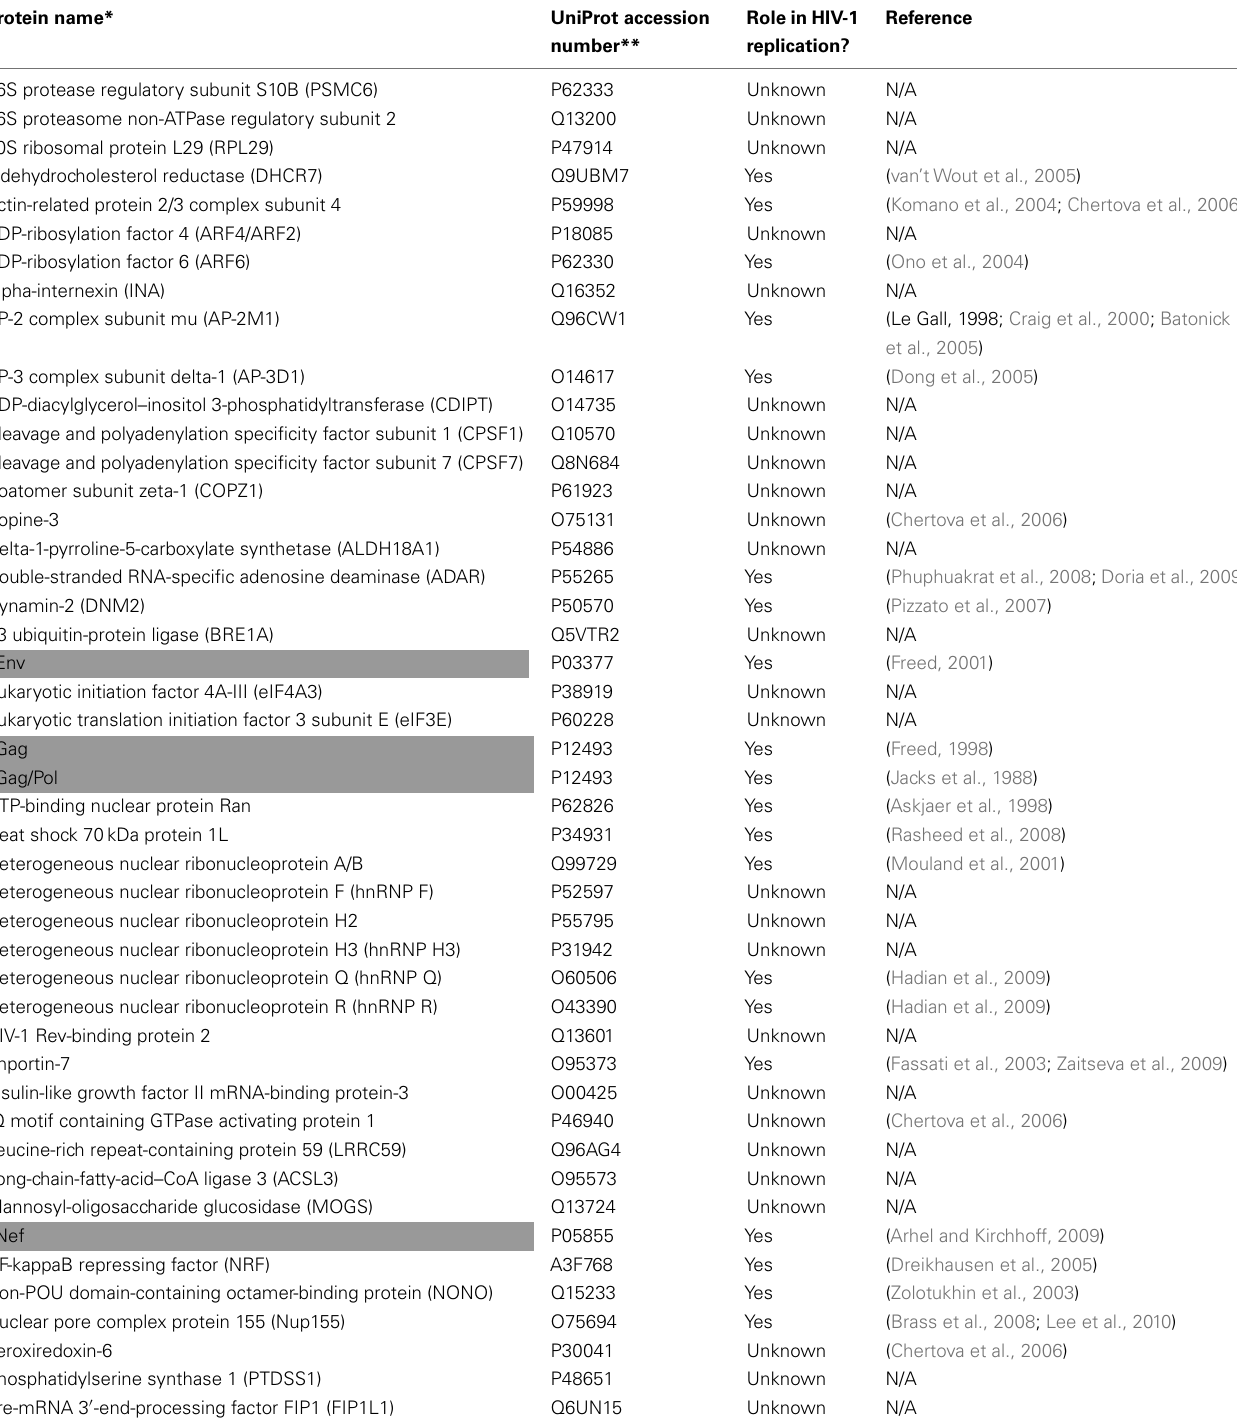
Table 1 | Unique proteins identified by mass spectrometry in Staufen1-HIV-1